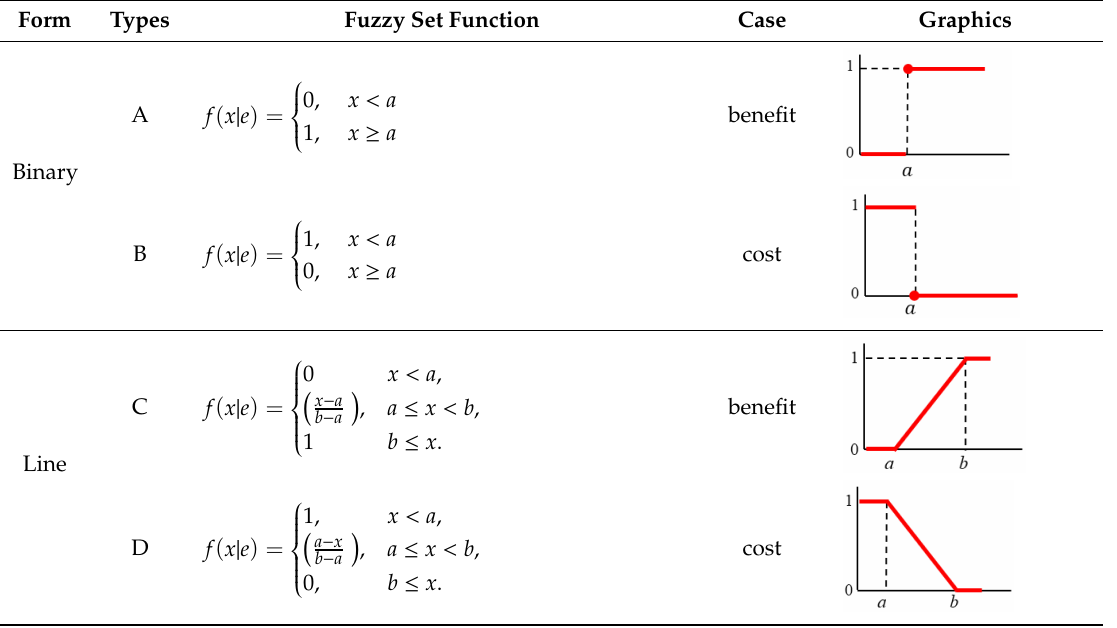
Table 3. Possible cases’ utility function for the nine